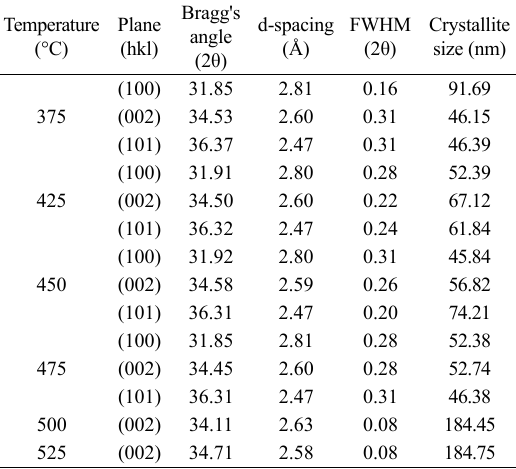
from an oxygen-deficient material to a more stoichiometric zinc oxide is the (002) preferred orientation. This causes the sheet resistance to increase for temperatures above 450℃. The growth rate of each crystallographic plane differs based on crystal orientation and surface energy. The (002) to (100) polar planes ratio of intensity (I / I ) can affect 002 100 the photocatalytic activity due to the ZnO polar planes' contribution in the formation of oxygen vacancies 40 . The full width at half maximum (FWHM), crystallite sizes, peak positions, and d-spacing are listed in Table 1 (calculated by the PANalytical X'pert Highscore Plus software). Based on the XRD patterns, the dominant orientation of (002) was at 2θ ≈ 34º which is in agreement with a few other works 14,41- 44 . The other observed peaks were (100), (101), and (110). Hence, the crystallites were highly oriented with their c-axes which are perpendicular to the substrate plane 45 . Table 1. Structural properties of ZnO thin films prepared at different substrate temperatures Bragg's Temperature Plane angle (°C) (hkl)